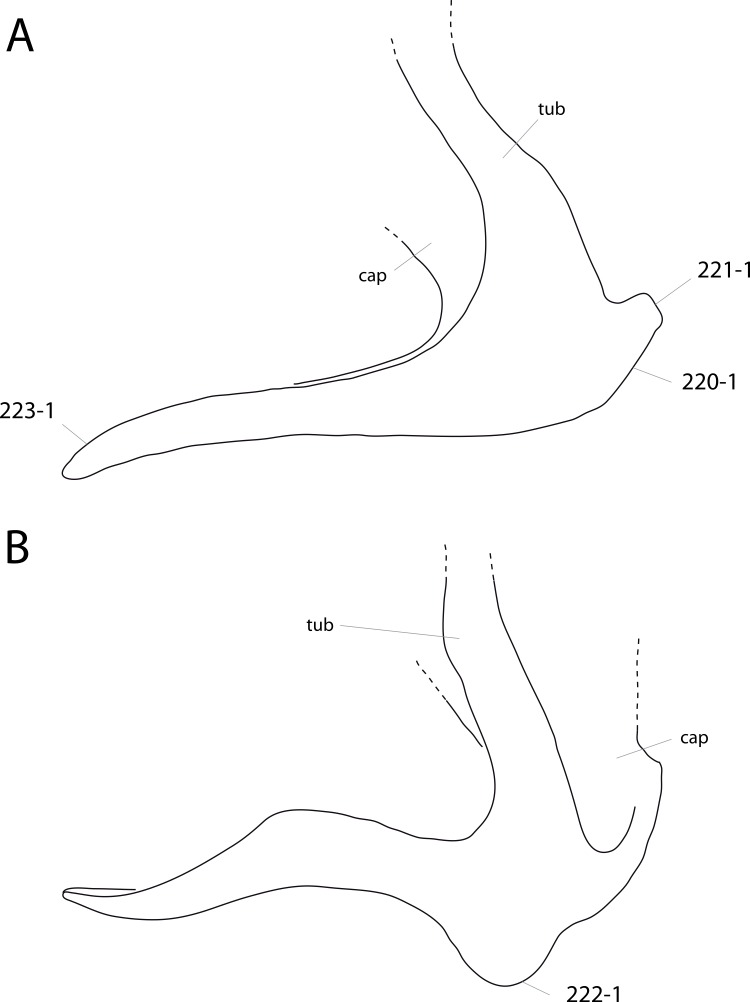
Apatosaurine posterior cervical ribs.Posterior cervical ribs of Brontosaurus parvus UW 15556 (A; after Gilmore, 1936) and Apatosaurus louisae CM 3018 (B; after Gilmore, 1936) in right lateral view (B inverted). Note the short, reduced anterior projection (A; C220-1), the pointed anterior process (A; C221-1), the ventrolateral process (B; C222-1), and the downwards curving posterior process (A; C223-1). Abb.: cap, capitulum; tub, tuberculum. Scaled to same length.